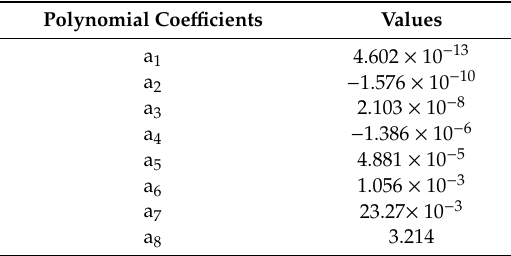
Table 2. Values of a for SOC-OCV function expressed in Equation (36).